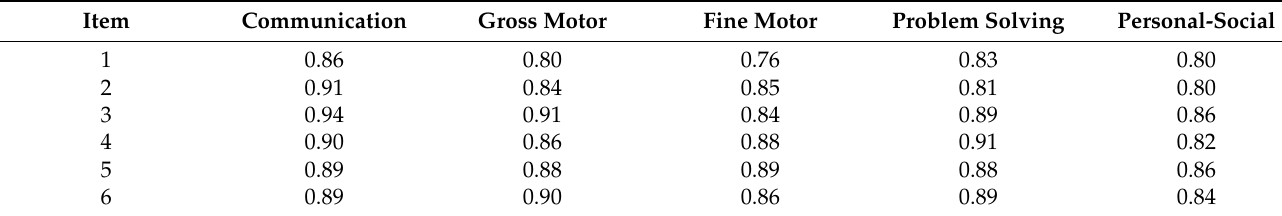
Table 5. Factors loading of ASQ-3.